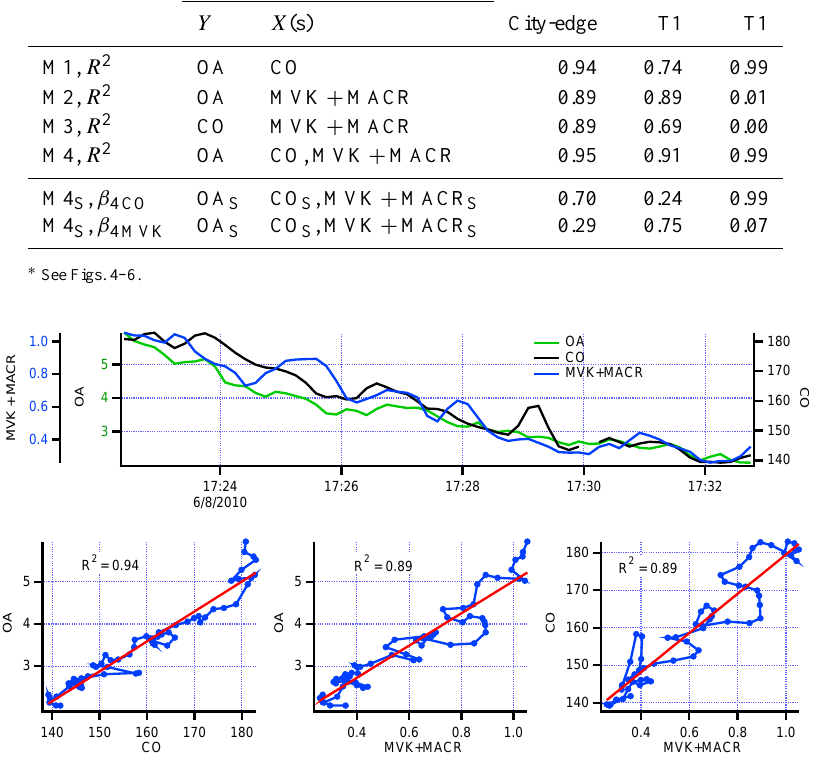
Table 6. Coefficients of determination for models M1–M4 and standardized regression slopes for model M4 S for three transects. Model Variables